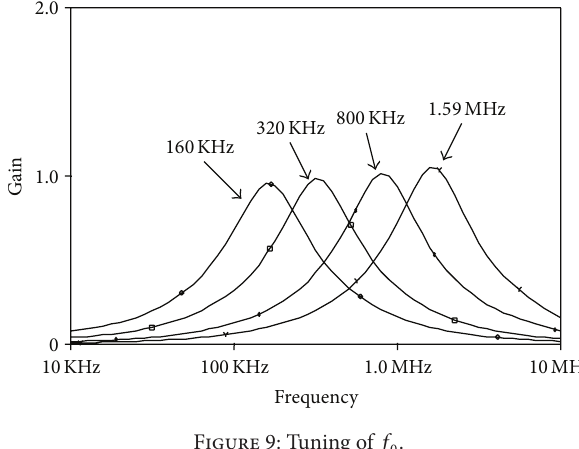
Figure 9: Tuning of 𝑓 0